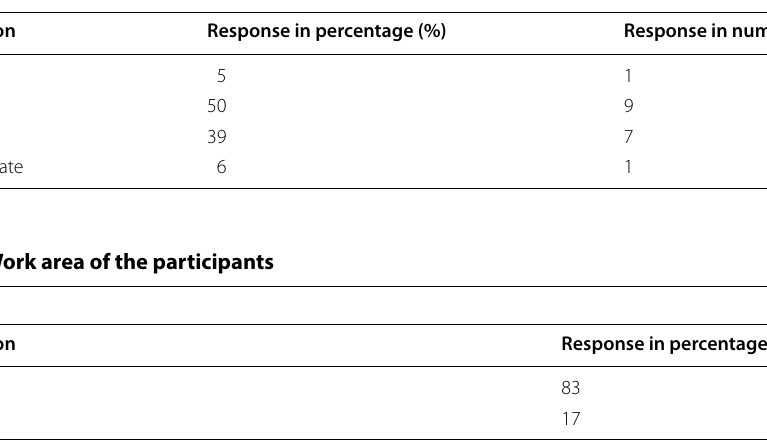
Table 1 Educational level of the participants (N